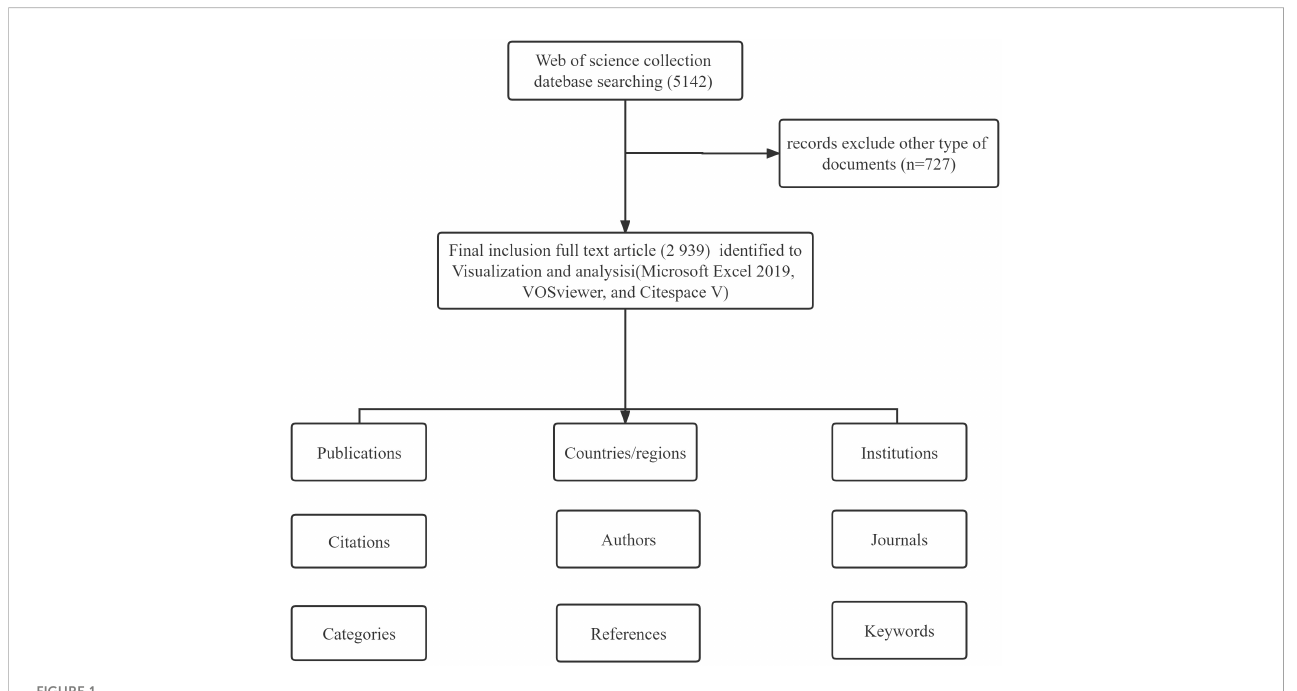
FIGURE 1 Flowchart of the research literature